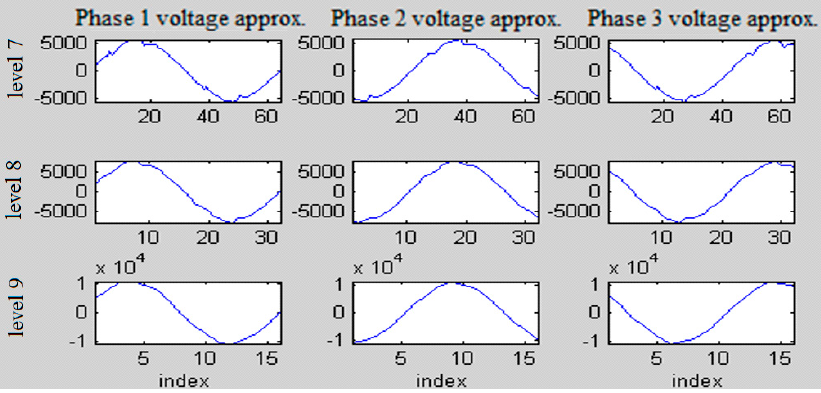
Figure 10. Vectors of approximations for voltages, levels 7–9, first case study.